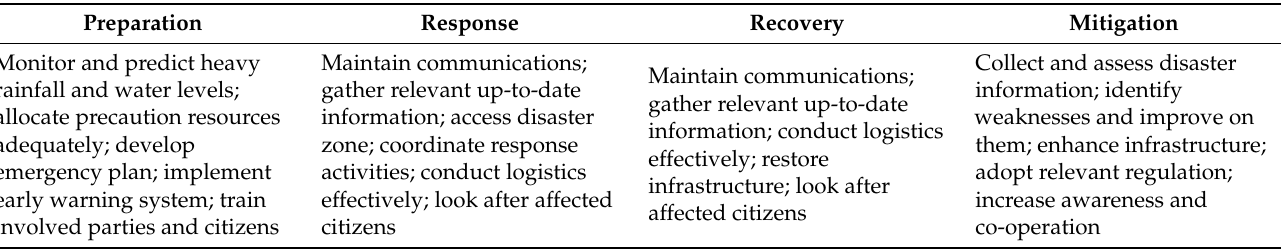
Table 1. Challenges for cities when dealing with